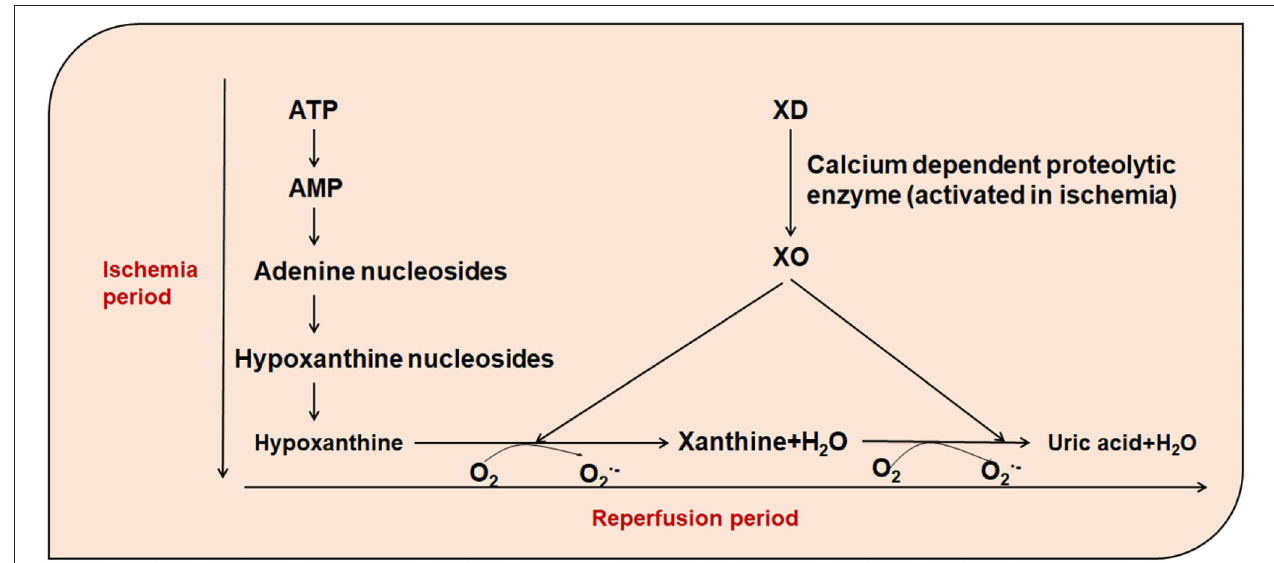
FIGURE 1 | The role of xanthine oxidase in the presence of increased free-radicals. ATP, Adenosine triphosphate; AMP, Adenosine monophosphate; XO, Xanthine oxidase; XD, xanthine dehydrogenase; O 2 , oxygen; O . − 2 , Superoxide Anion.